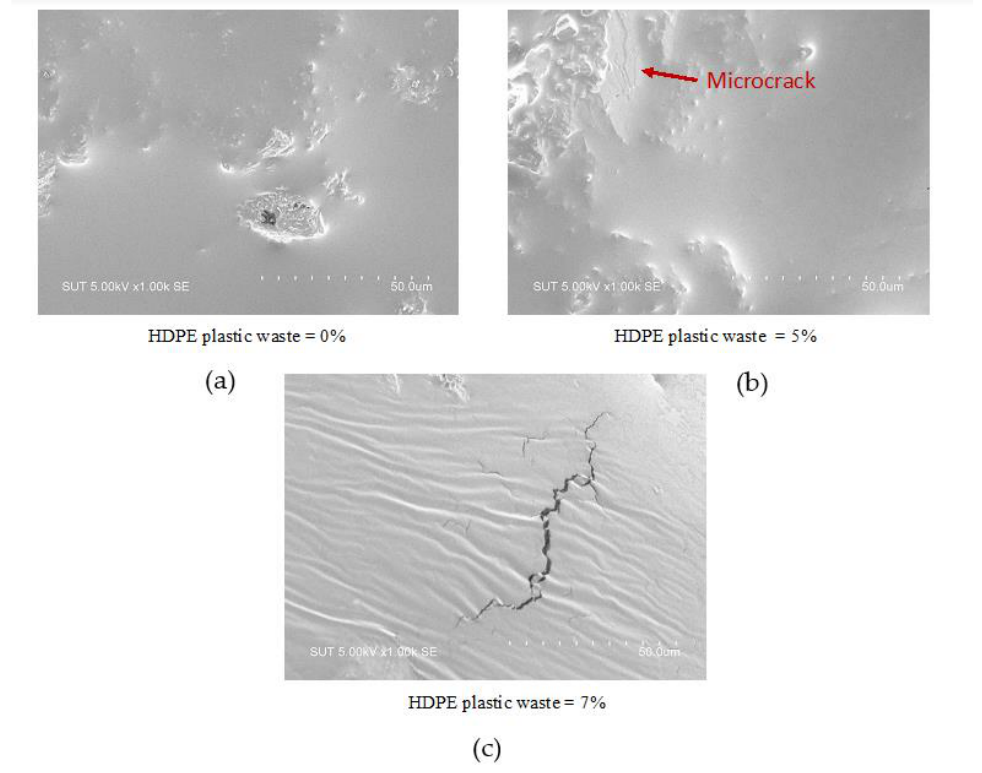
Figure 6. 1000 × -magnified SEM images of HDPE-ACP at HDPE plastic waste: ( a ) 0%; ( b ) 5%; and ( c ) 7%.